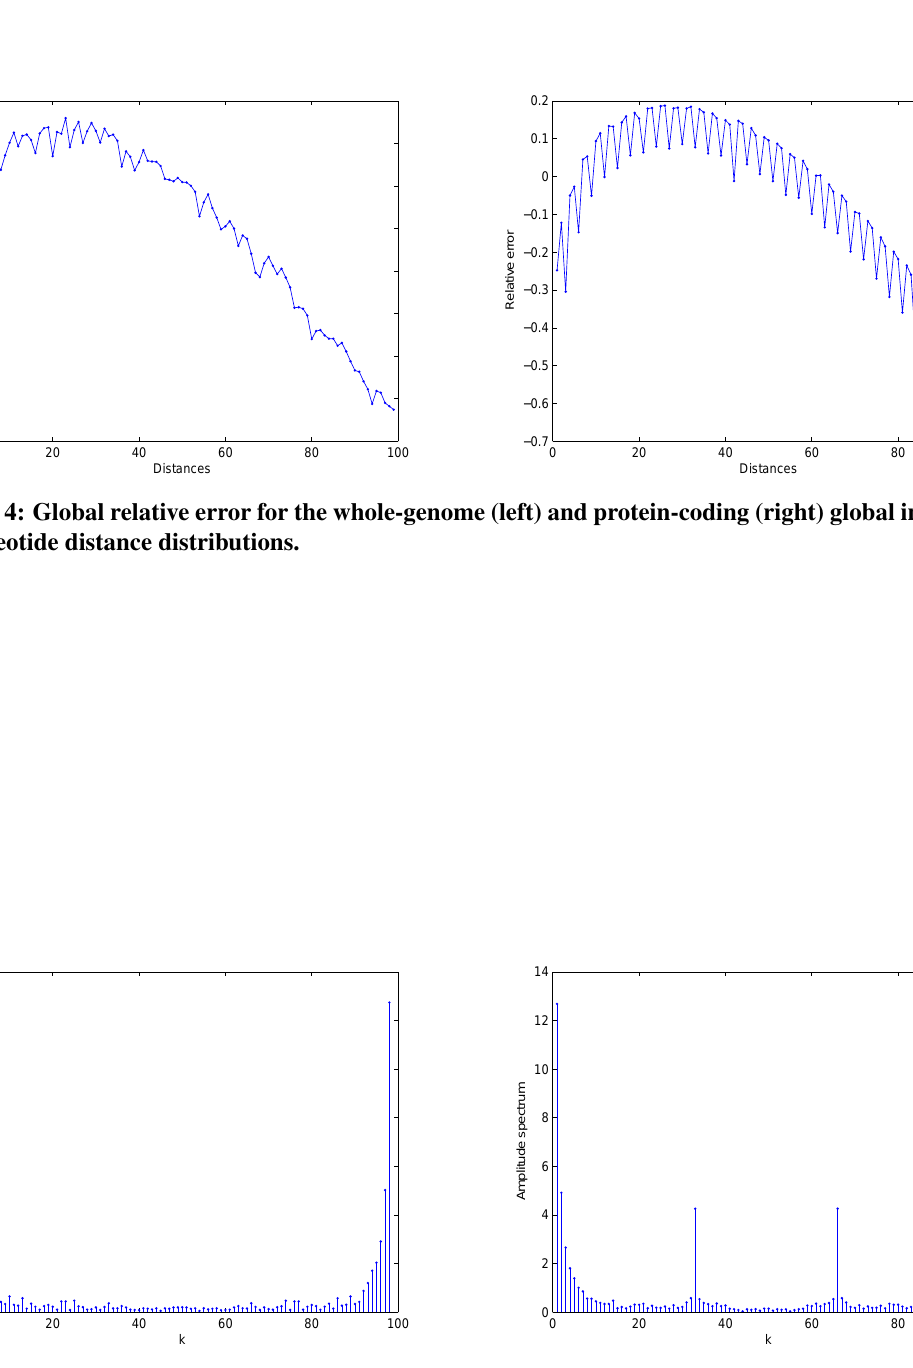
Figure 5: Absolute value of the discrete Fourier transform (DFT) of the relative error in the whole- genome (left) and protein-coding (right) global inter-dinucleotide distance